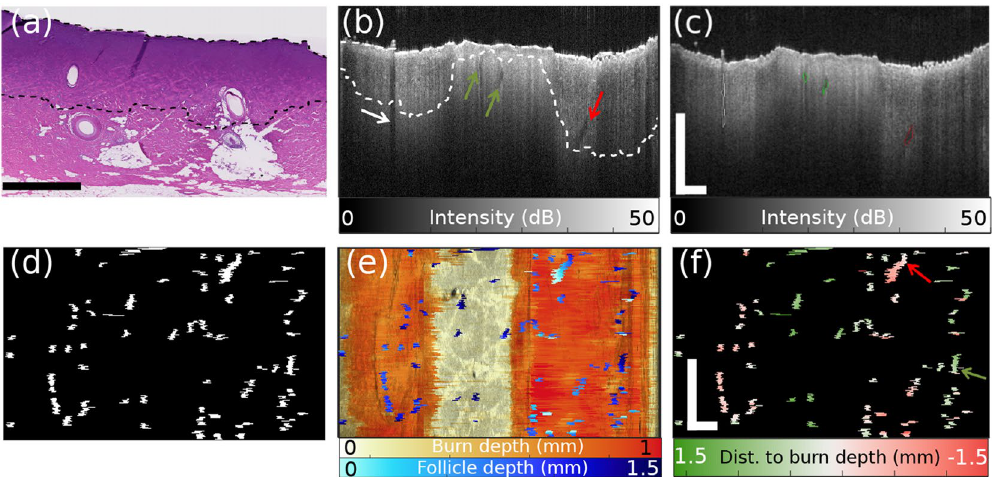
Figure 5. Histological ( a ) examples of mature follicles below (left) and above (right) our DOP-based, automatically-determined collagen damage boundary. In ( b ), we provide examples of hair shaft shadow (white arrow), intact superficial hair shaft cross section (green arrows), and deep follicle within burn zone (red arrow), and the automatic detection of these structures using our image processing routine ( c ), with the shadow being excluded from further processing. Maps were generated for en face visualization of the locations of identified follicles ( d ). In ( e ), the depths of those follicles below the tissue surface are encoded against the DOP-based burn depth estimation (see Fig. 2). Our healing potential map directly compares these two parameters as − depth Distance (Dist.) to burn depth = depth follicle burn , where follicles above the border of collagen injury (displayed in green) would be presumed undamaged, and follicles below this border (displayed in red) would be presumed at risk for